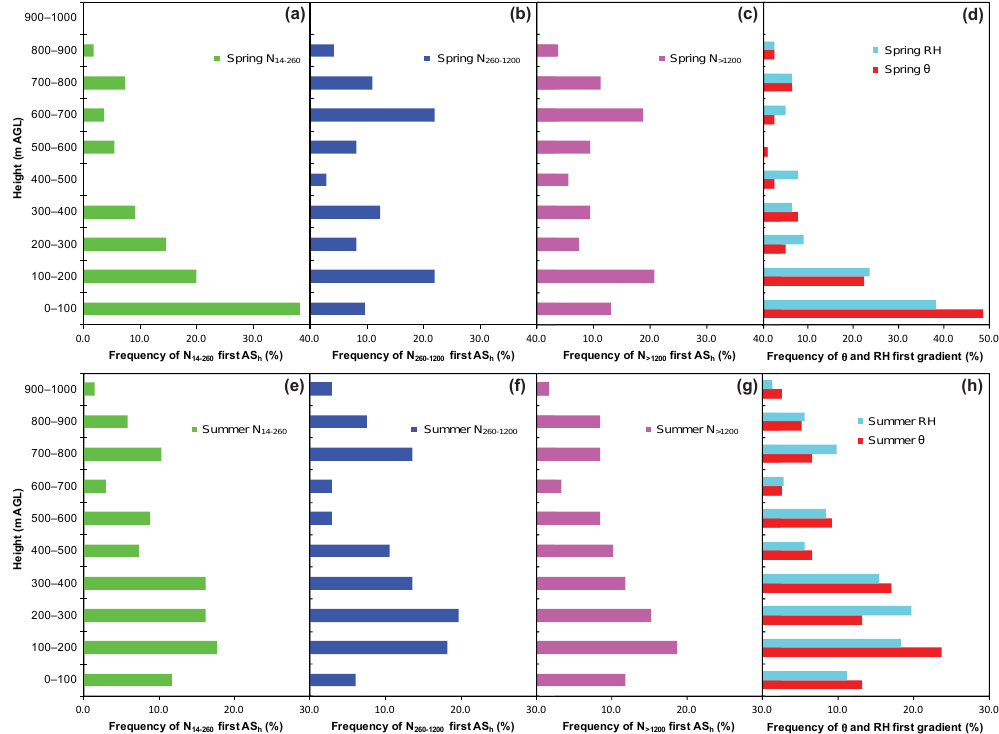
Figure 3. Vertical frequency distribution of the AS h for N 14 − 260 , N 260 − 1200 , N > 1200 , θ and RH during spring in panels from (a) to (d) and in summer in panels from (e) to (h)